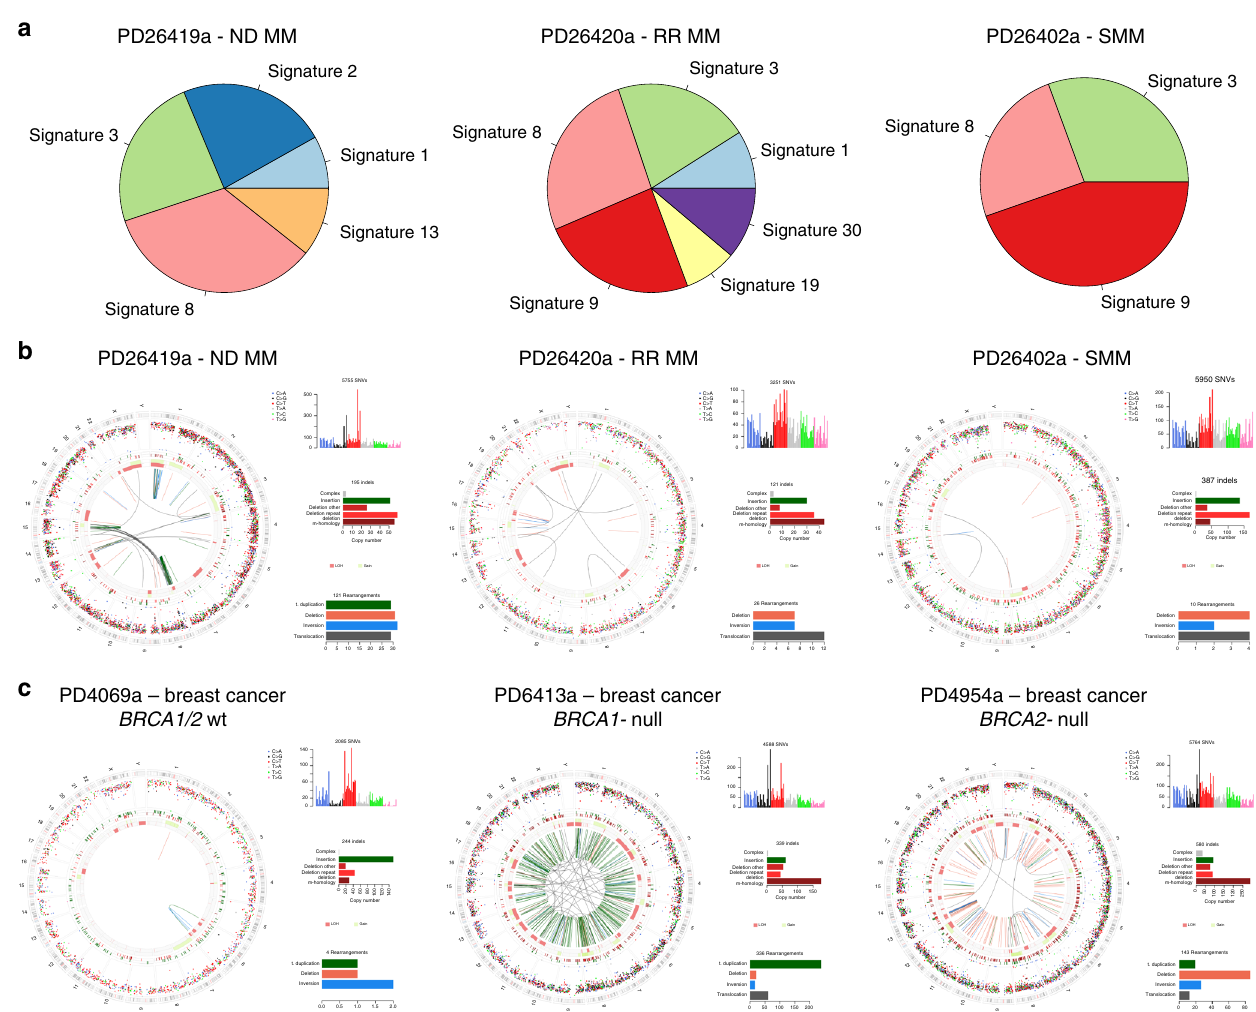
Fig. 3 Absence of BRCA-driven HRD in MM. a Pie charts showing the relative signature composition according to DeconstructSig in three MM cases, without a prior knowledge of which signatures are involved or detected by NNMF. Testing all 30 COSMIC mutational signatures, Signature 3 is extracted is all samples. b Circos plot of three MMs (ND = newly diagnosed; RR = relapsed/refractory; SMM = smoldering MM) where deconstructSig extracted a signi fi cant Signature 3 contribution. From the external ring to the internal: mutations, (vertically plotted according to their inter-mutational distance and where the color of each dot represents the mutation class), indels (dark green = insertion; and brown = deletion); copy number variants (red = deletions, green = gain), rearrangements (blue = inversion, red = deletions, green = ITD, black = translocations). PD26419a is the only patient with a slightly high HRDetect score when analyzed including Signature 3. c Circos plots of a breast cancer sample without BRCA de fi ciency (PD4069a), one with BRCA1 de fi ciency (PD6413a) and one with BRCA2 de fi ciency (PD4954a). The MM genomic landscape shows signi fi cant differences to the two BRCA-de fi cient breast cancers, in particular in terms of numbers of indels and SVs, suggesting BRCA-driven HRD is not present in the MM samples